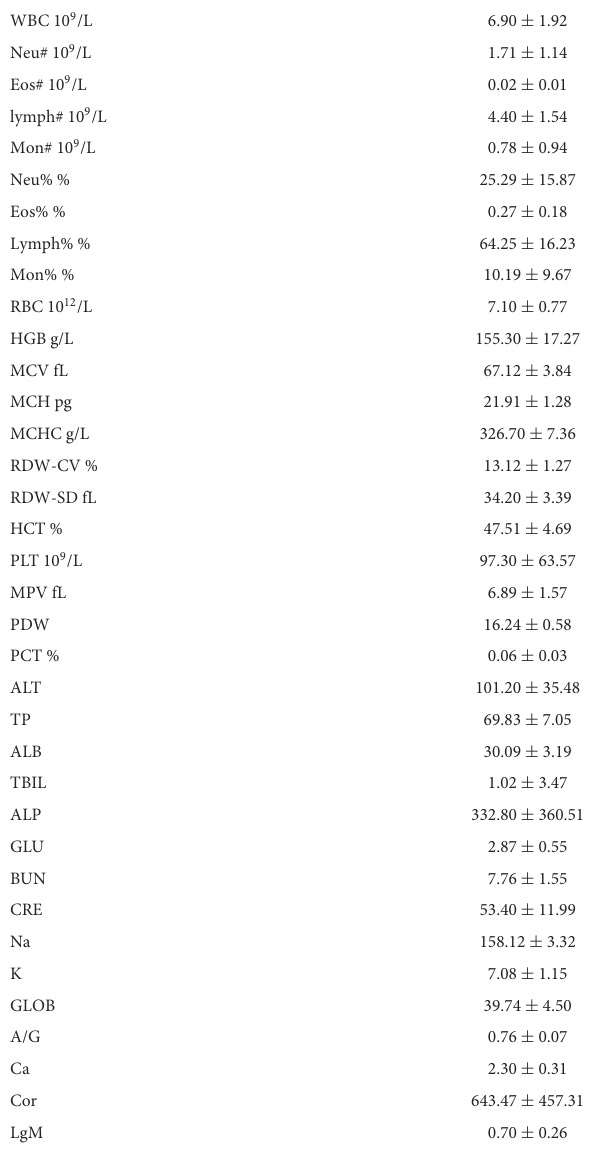
TABLE 2 Blood biochemical parameters of pangolin